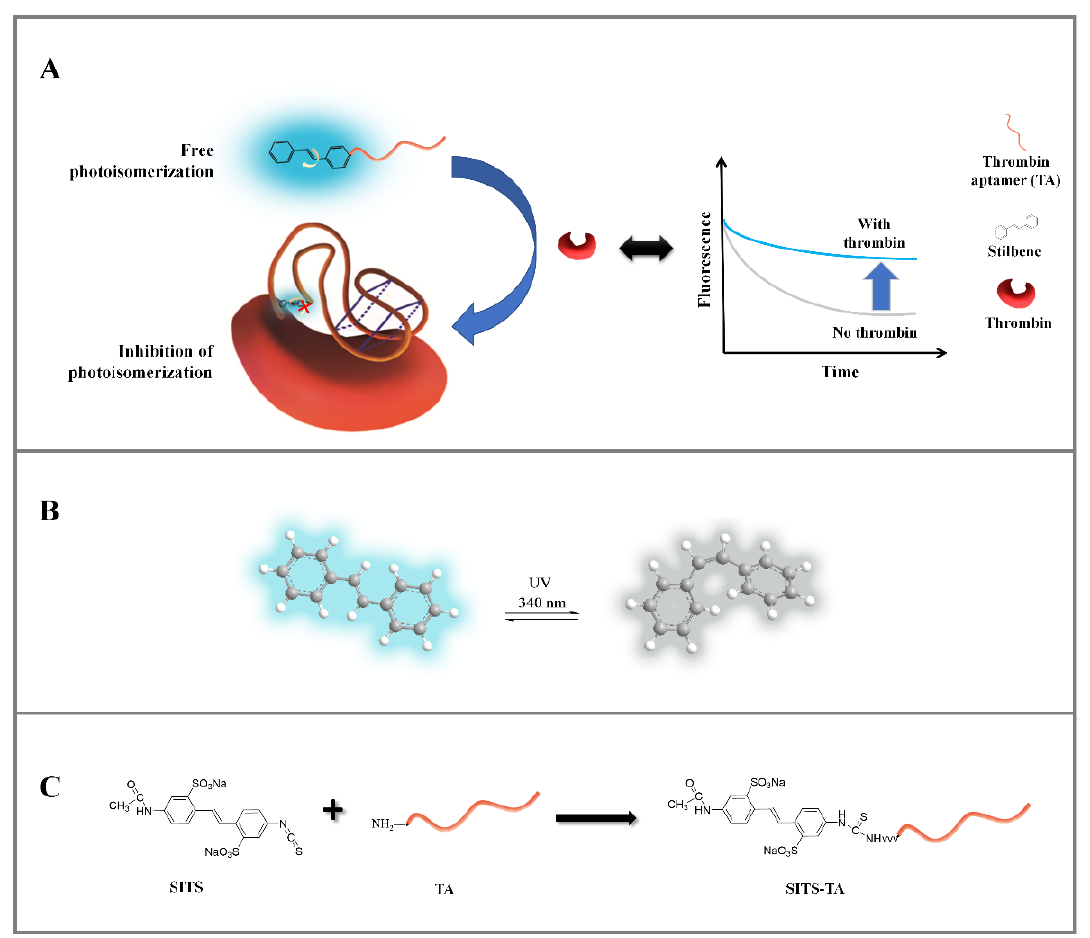
Figure 1. ( A ) Schematic representation of the proposed sensing strategy for the detection of thrombin based on variation of the stilbene fluorescence attenuation. ( B ) The configuration transition and fluorescence change of stilbene under specific wavelength irradiation (i.e., λ ex = 333 nm). ( C ) Schematic diagram on the synthesis reaction of SITS-thrombin aptamer (SITS-TA).